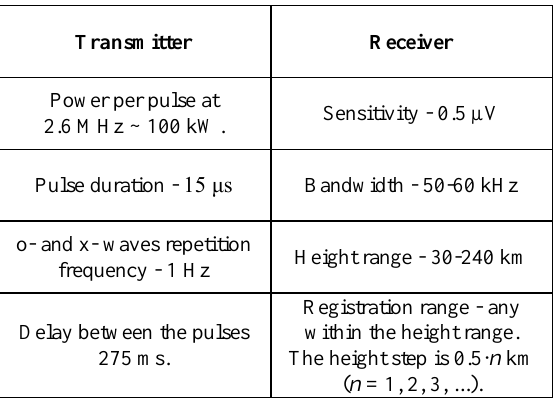
Table 1. Technical characteristic of the